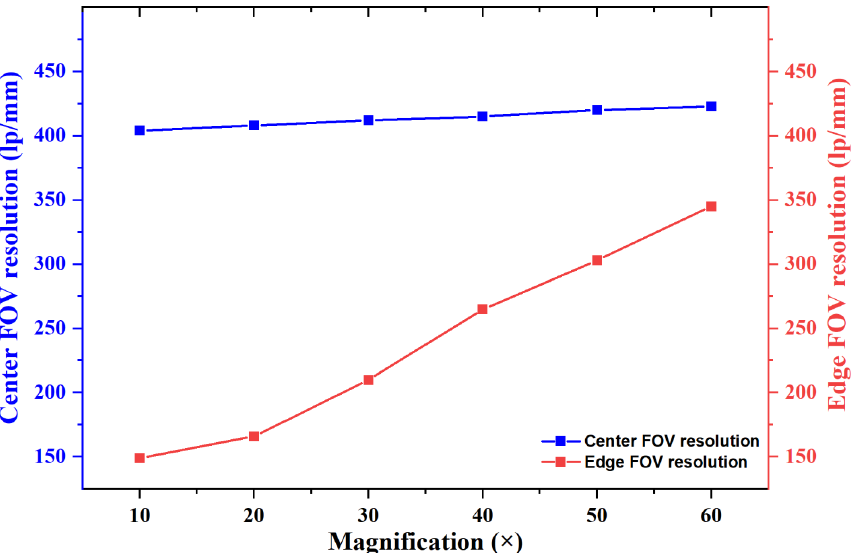
Fig. 5 Relationship between resolution limit (dropping to 10% of maximum MTF) and magnification. The blue curve represents the central FOV resolution. The red curve represents the edge FOV